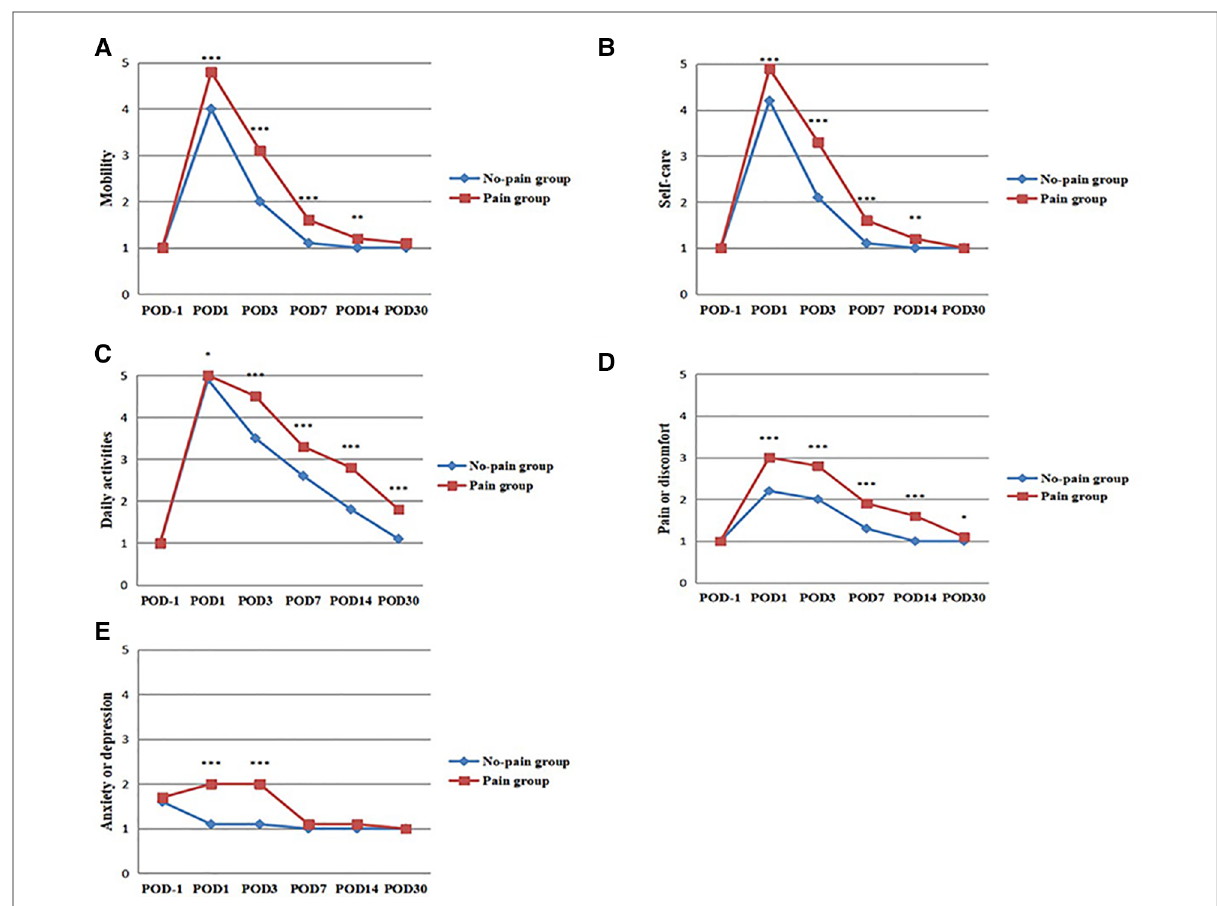
FIGURE 4 Comparison of EQ-5D-5L scores between pain and non-pain patients. ( A ) Mobility scores were compared between the two groups. ( B ) Self-care scores were compared between the two groups. ( C ) Daily activities scores were compared between the two groups. ( D ) Pain or discomfort scores were compared between the two groups. ( E ) Anxiety or depression scores were compared between the two groups. * P <0.05, ** P <0.01, *** P <0.001, the difference was statistically signi fi cant. POD=Postoperative